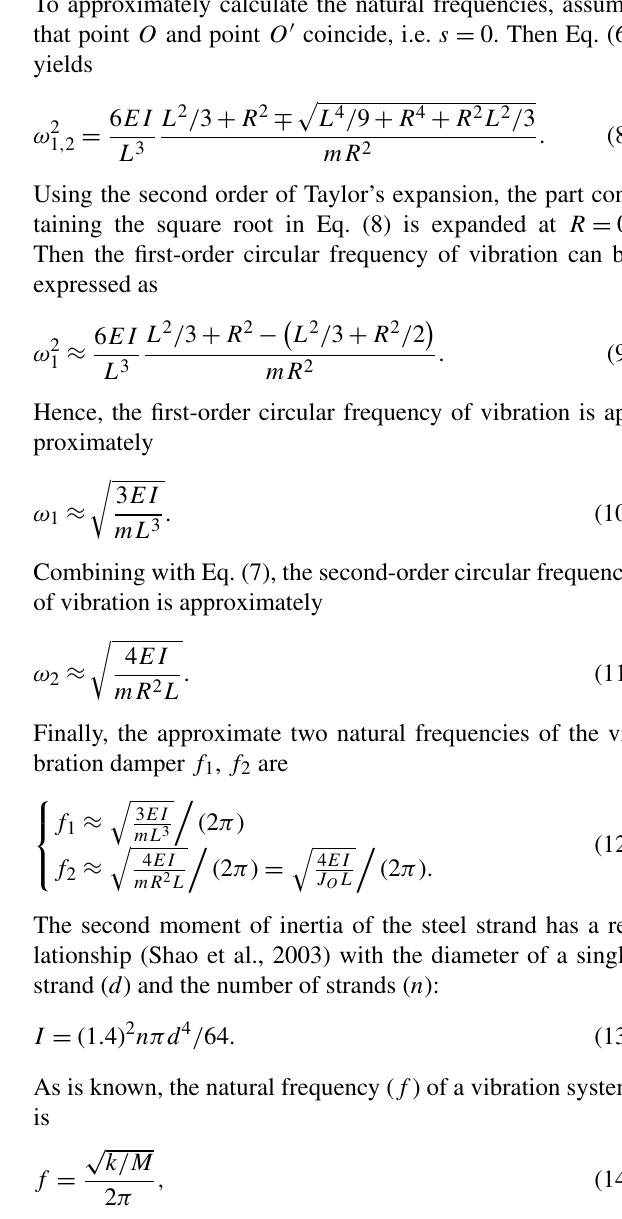
of inertia of the counterweight rotating around an axis